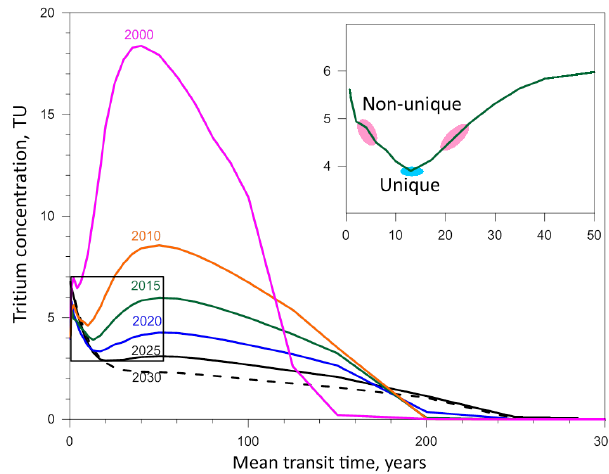
Figure 8. Simulated tritium concentrations in Hokkaido river water for the years 2000, 2010, 2015, 2020, 2025, and 2030 vs. ground- water MTT. A factor of 2.0 was used to scale the Tokyo input with E70%PM. The inset shows 2015 tritium concentrations with a unique MTT indicated in blue and non-unique MTTs (two possi- bilities) indicated in